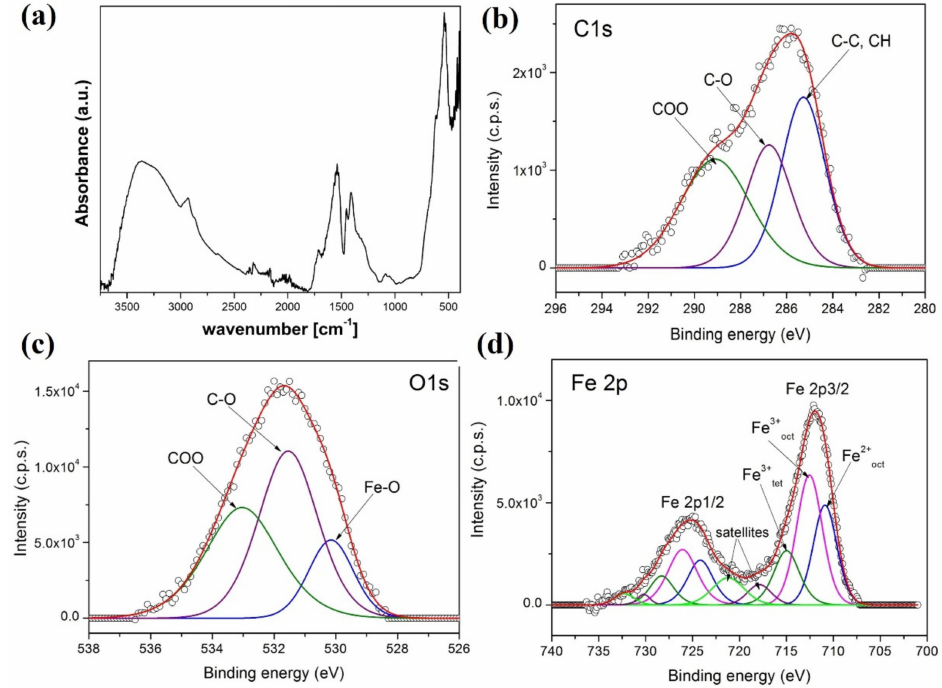
Figure 5. ( a ) FTIR spectrum of the magnetic nanoclusters coated with polyacrylic acid. ( b ) The high-resolution XPS spectra of C 1s, ( c ) O1 s, and ( d ) Fe 2p core-levels for the clusters coated with polyacrylic